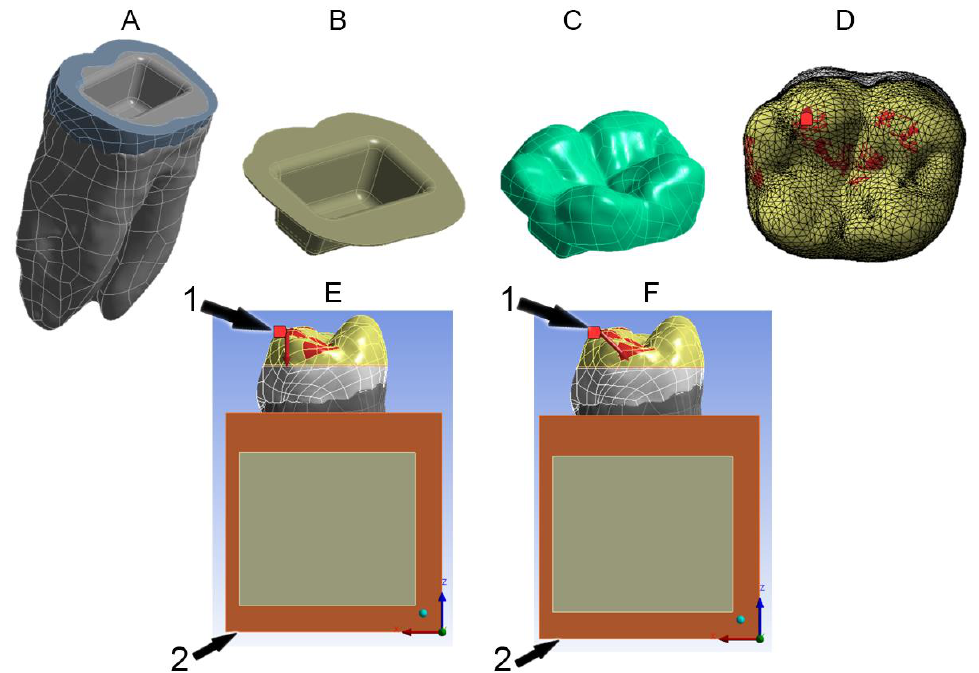
Figure 2. ( A ): dental tissues; ( B ): cement layer; ( C ): endocrown; ( D ): loading points on endocrown; ( E ): axial loading; ( F ): oblique loading. 1: applied force and 2: fixed support (inferior surface of cor- tical bone).